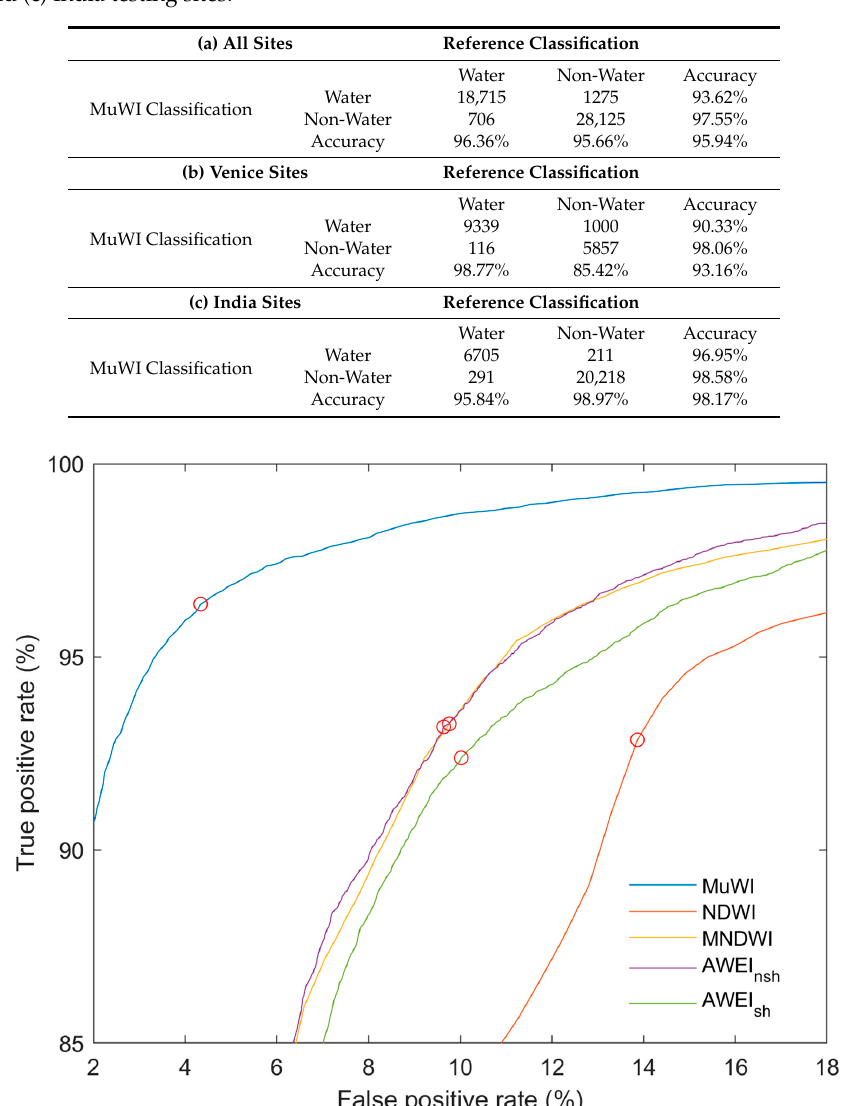
Figure 3. Receiver Operator Characteristic (ROC) curves of water indexes. Red circles indicate the optimum index thresholds.